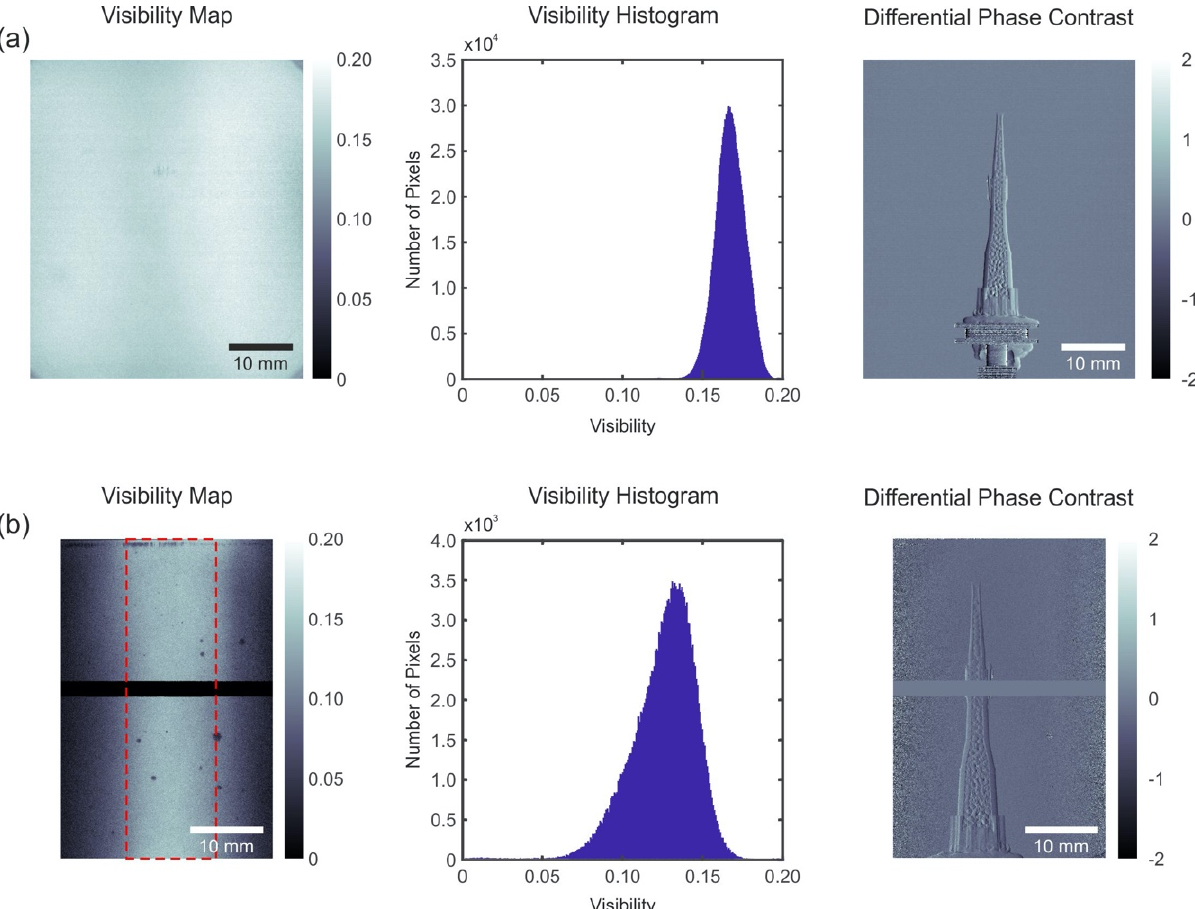
Figure 4. X-ray grating test results. Visibility map, visibility histogram and differential phase contrast image for two configurations shown in Table 2: ( a ) configuration 1; ( b ) configuration 2. The visibility histogram in case ( a ) was measured through the whole area, while in case ( b ) only in the central part outlined by the dash line. The visibility reduction in the side areas of case ( b ) is due to a twice higher aspect ratio of the G2 grating lines and almost a twice shorter interferometer length, which strongly limits the acceptance angle of the flat gratings. Details on the measurements can be found elsewhere [2].